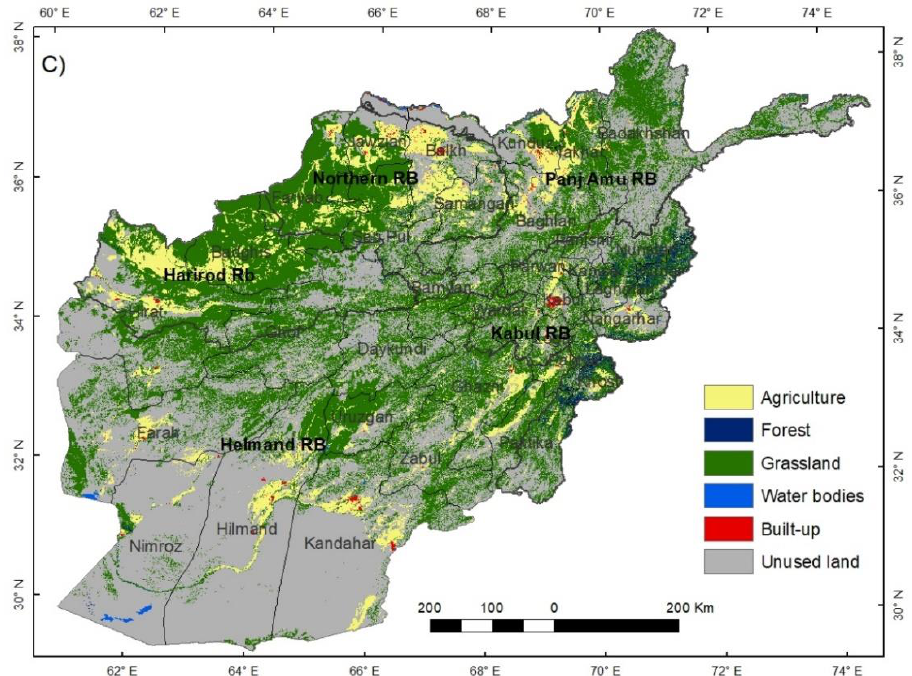
Figure 4. LULC maps of Afghanistan in ( A ) 2000; ( B ) 2010; ( C ) 2020.